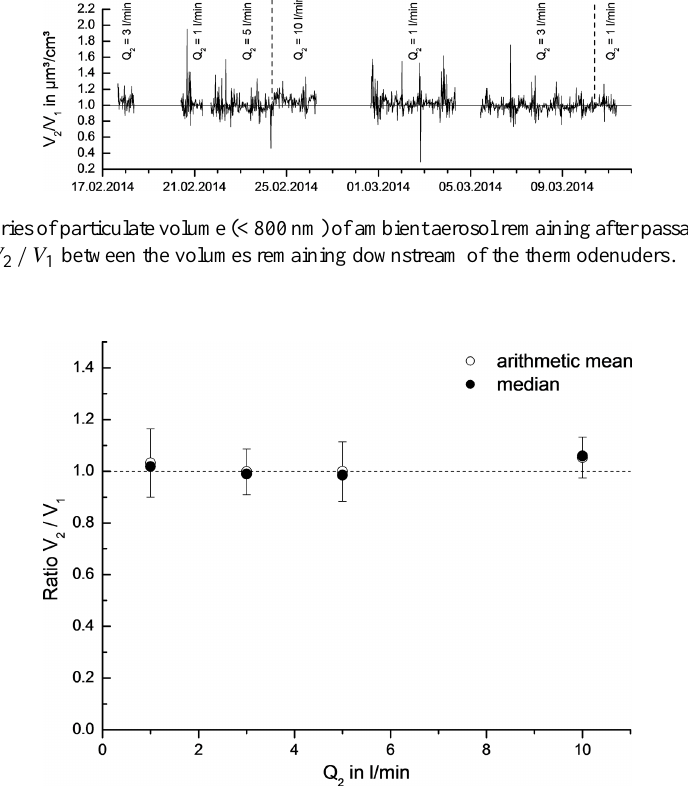
Figure A3. Ratio V 2 /V 1 between the remaining volumes as a function of the sampling flow through thermodenuder 2. Error bars correspond to standard